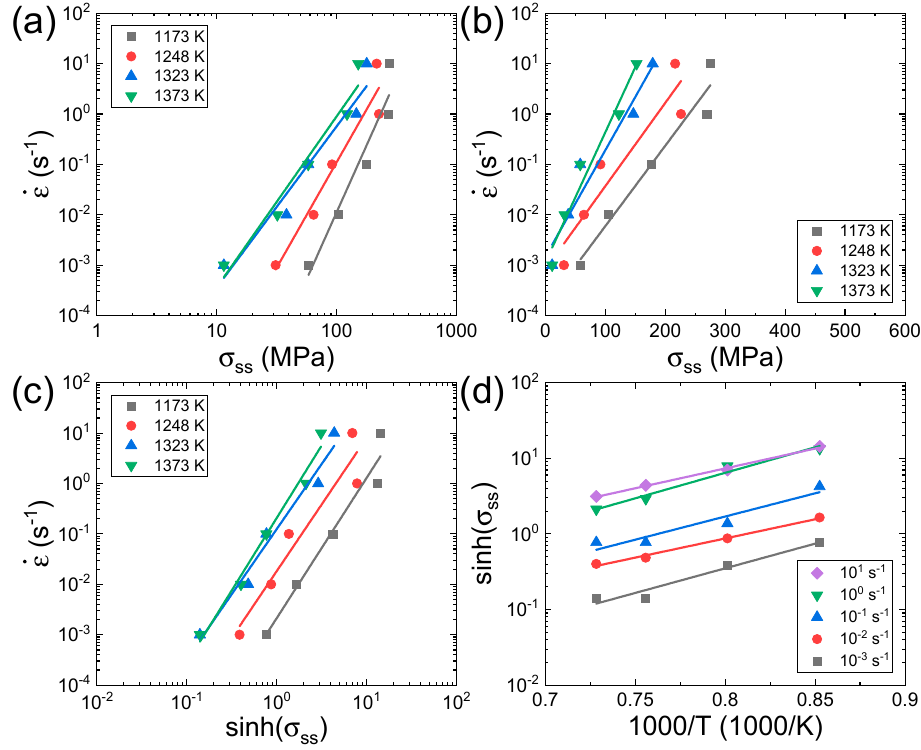
. . . Figure 3. Plots of ( a ) log ε − log σ , ( b ) log ε − σ , ( c ) log ε − log ( sinh ( α σ )) , and ( d ) log ( sinh ( α σ )) − 1000 Figure 3. Plots of ( a ) log 𝜀(cid:4662) − log 𝜎 , ( b ) log 𝜀(cid:4662) − 𝜎 , ( c ) log 𝜀(cid:4662) − log(sinh(𝛼 𝜎)) , and ( d ) log(sinh(𝛼 𝜎)) − for the Al 0.7 CrMnFeCoNi HEA [62] at a given strain of 0.7. The subscript ‘ ss ’ in σ ss represents the steady (cid:2869)(cid:2868)(cid:2868)(cid:2868) (cid:3021) state. Reproduced/modified with permission from [62],